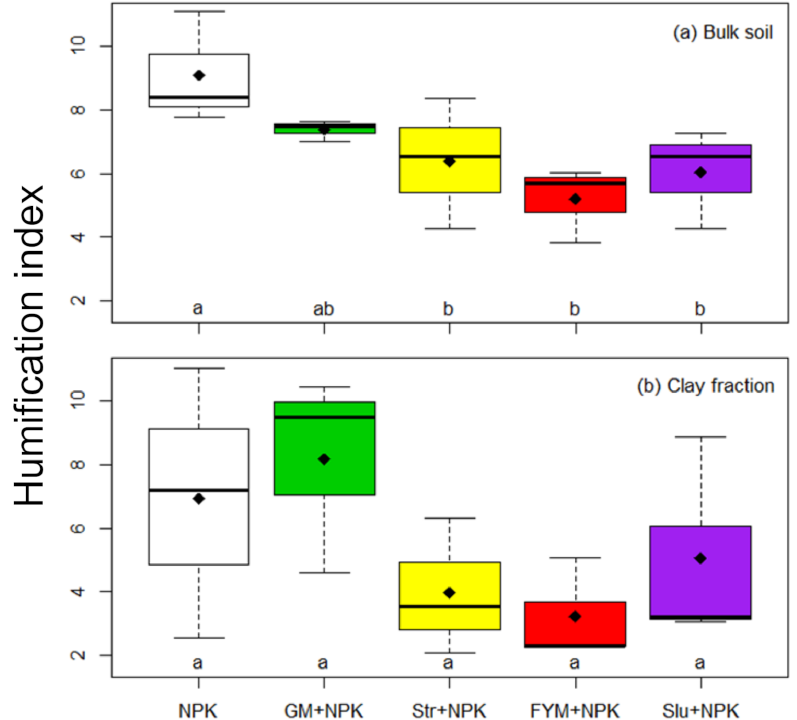
Figure 4. Humification index for bulk soils ( a ) and clay fraction ( b ) Di ff erent letters indicate significant di ff erences between treatments ( p < 0.05; n = 3). The centerline represents the median, the dot represents the mean, the lower and the upper lines of the boxplot represent the 25th and the 75th percentiles, and the box whiskers represent minimum and maximum values. NPK : mineral fertilization